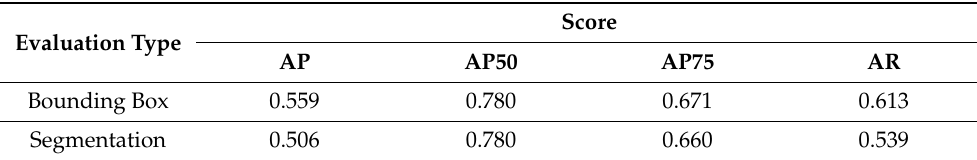
Table 6. Evaluation of Instance Segmentation Model.